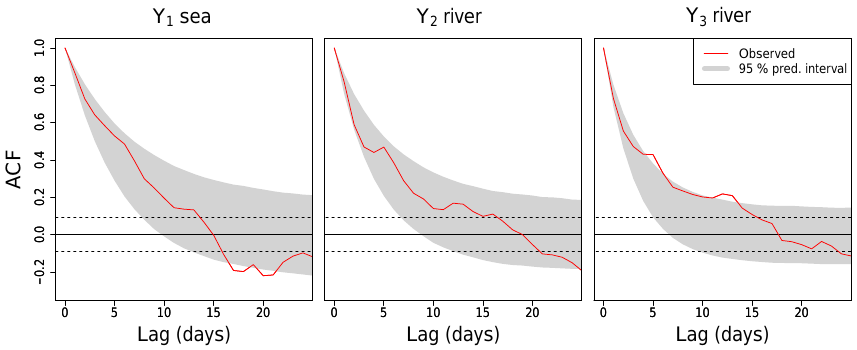
Figure E1. ACF of the observed time series (shown in red) against the ACF 95% confidence interval (grey) of the model (obtained through the Monte Carlo procedure). The dashed lines contain the 95% confidence interval defined by the ACF of a white noise process; i.e. outside this interval the ACF of the contributing variables Y is